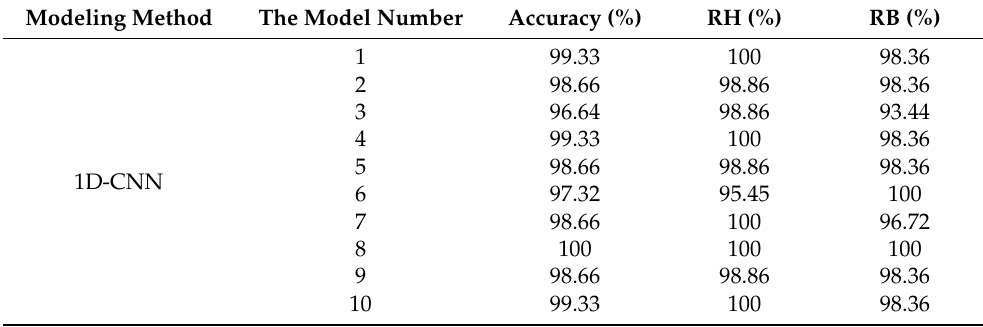
Table 4. The results of 10 parallel runs of the 1D-CNN discriminant model for pear quality.